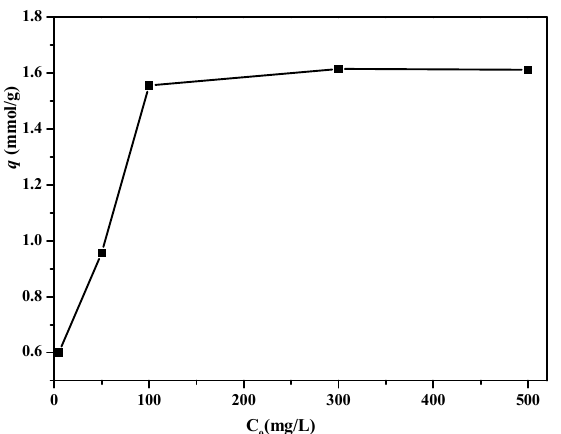
Figure 10. Effect of the initial boron concentration on boron uptake of PSF-diol membrane (pH = 8, T = 25 °C).